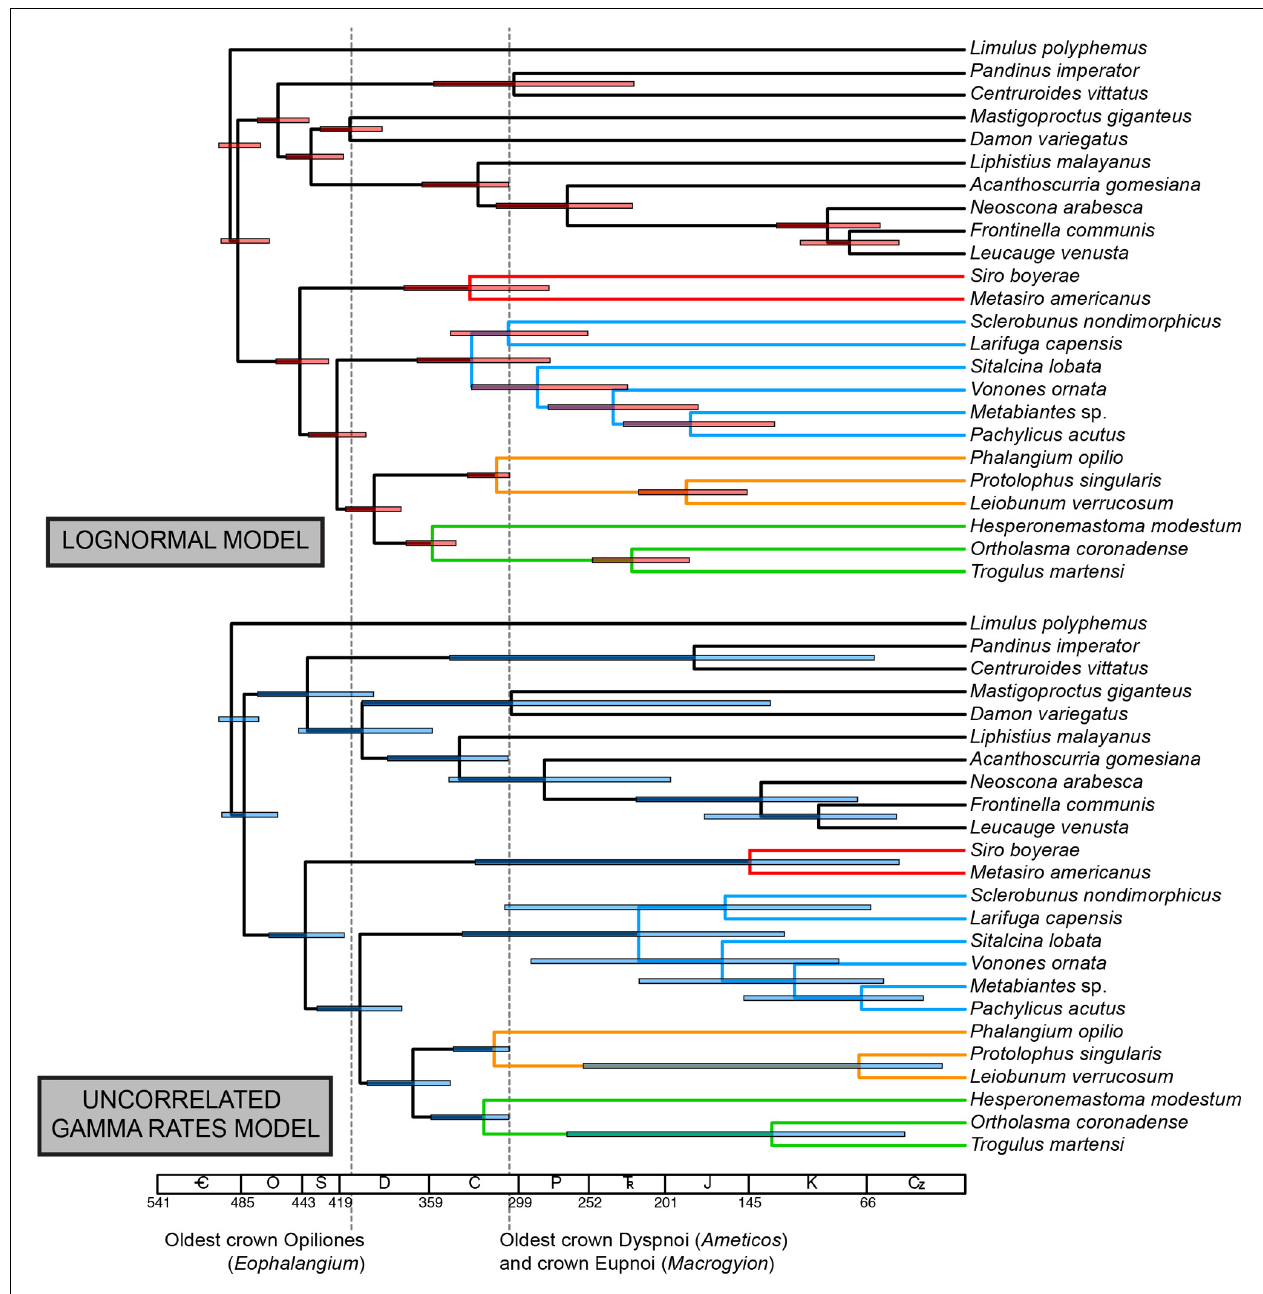
FIGURE 4 | Above: chronogram from node dating of phylogenomic matrix under the lognormal (autocorrelated) model. Below: chronogram from node dating of phylogenomic matrix under the